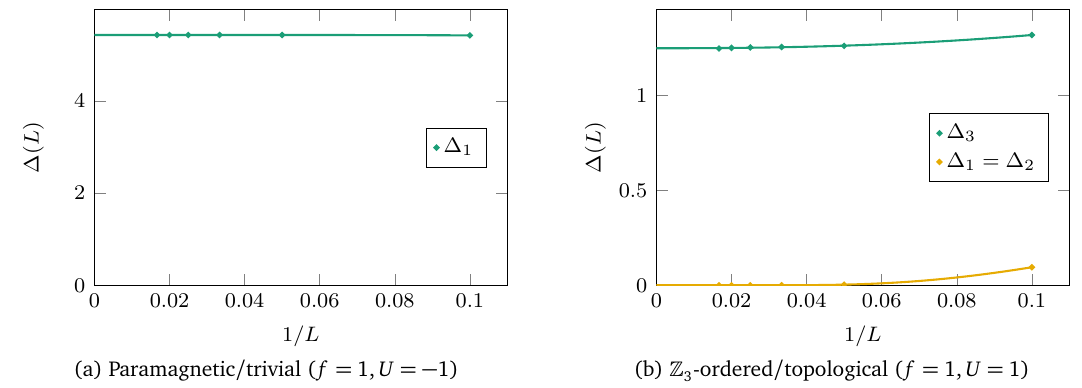
Figure 13: Energy gaps ∆ between the n th energy eigenstate and the ground n state, obtained from finite-size scaling for system sizes L = 10,20,...,60: (a) at f = 1, U = − 1 in the paramagnetic / trivial phase, (b) at f = U = 1 in the (cid:90) ordered / topological